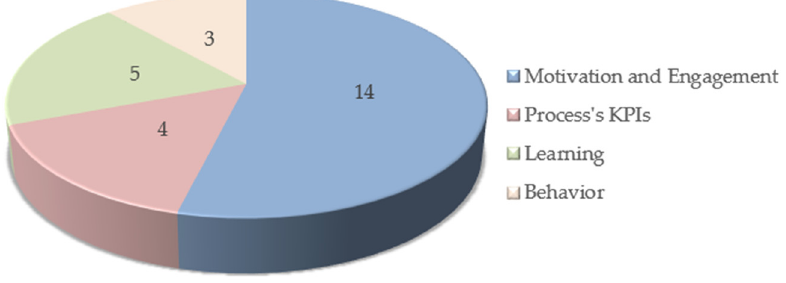
Figure 3. Number of primary studies by the issue they address. KPIs: key performance